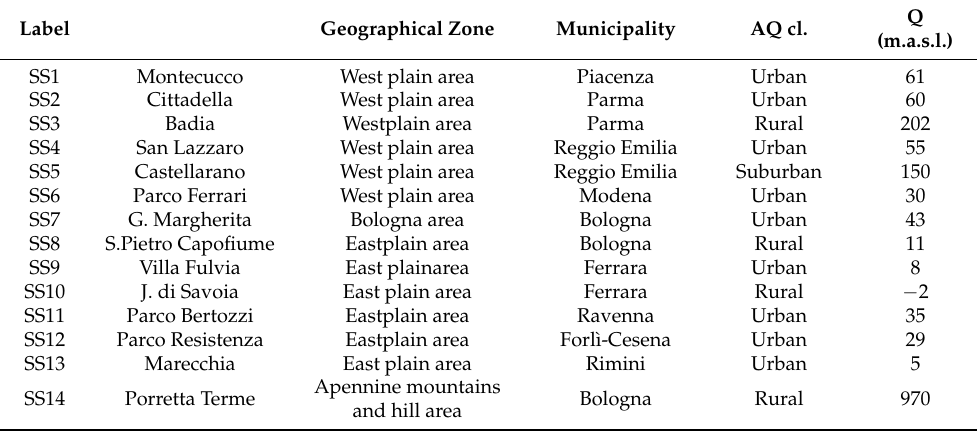
Table 1. Sampling sites: in the last two columns, the classification according to Air Quality Monitoring Network of Emilia-Romagna region (AQ cl.) and the altitude